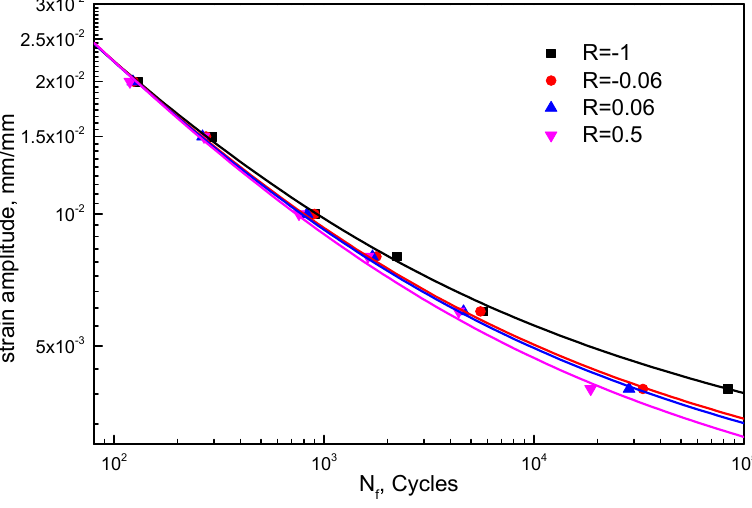
Figure 7. LCF lives of 2124-T851 under different strain ratios.